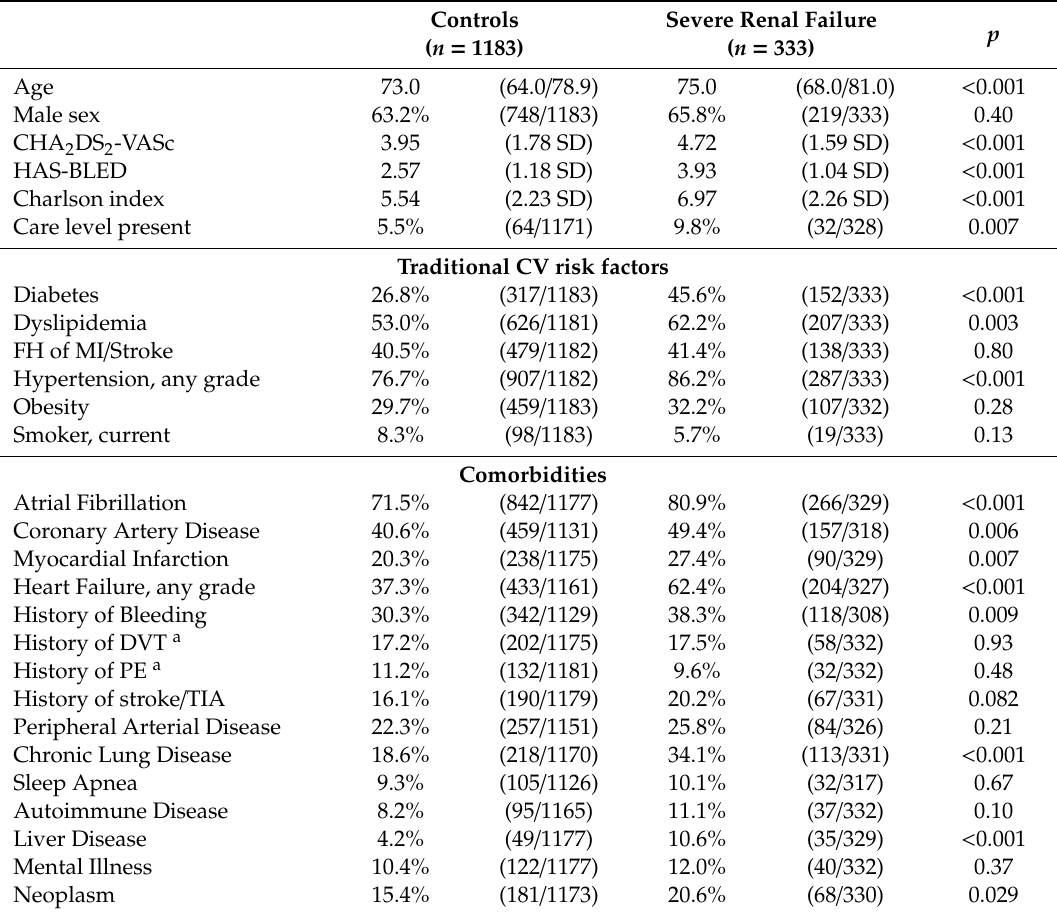
Table 1. The baseline characteristics of the study sample comparing patients with severe renal failure and controls in usual medical care.